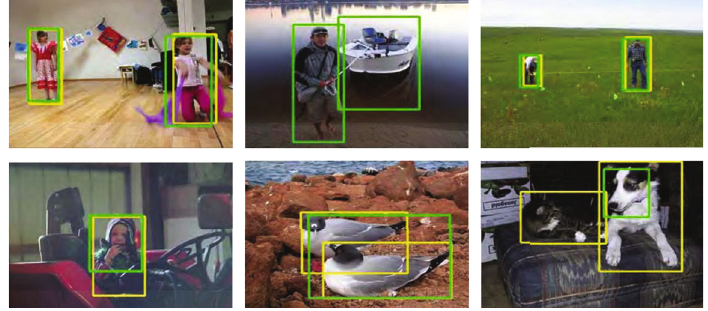
Figure 7: Examples of experimental